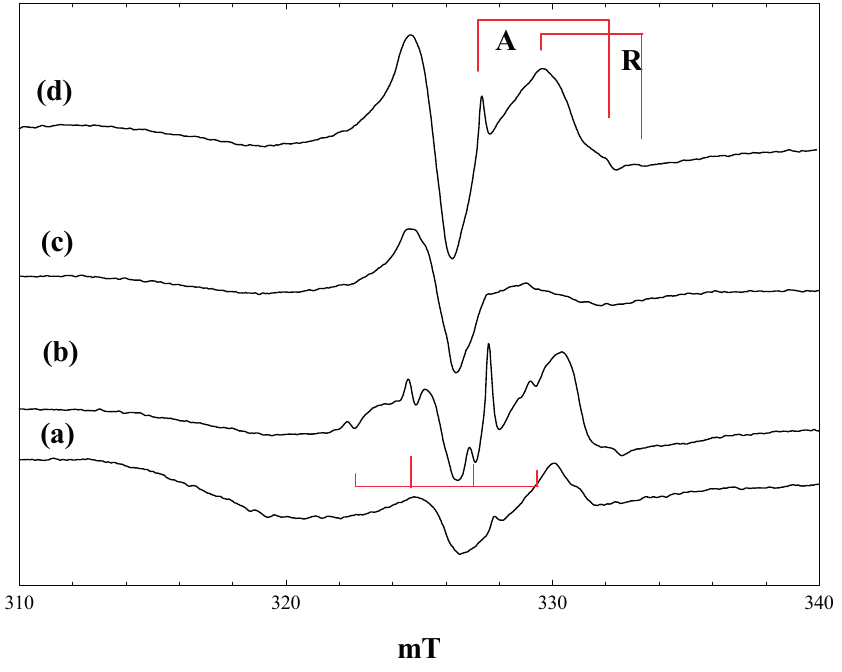
Figure 4. EPR spectra of P25 titania in a solution of maleimide in acetonitrile at 4 K. (a), During irradiation with low intensity 400 nm light; (b), during irradiation with high intensity 400 nm light; (c), during irradiation with high intensity broad band light; (d), after stopping